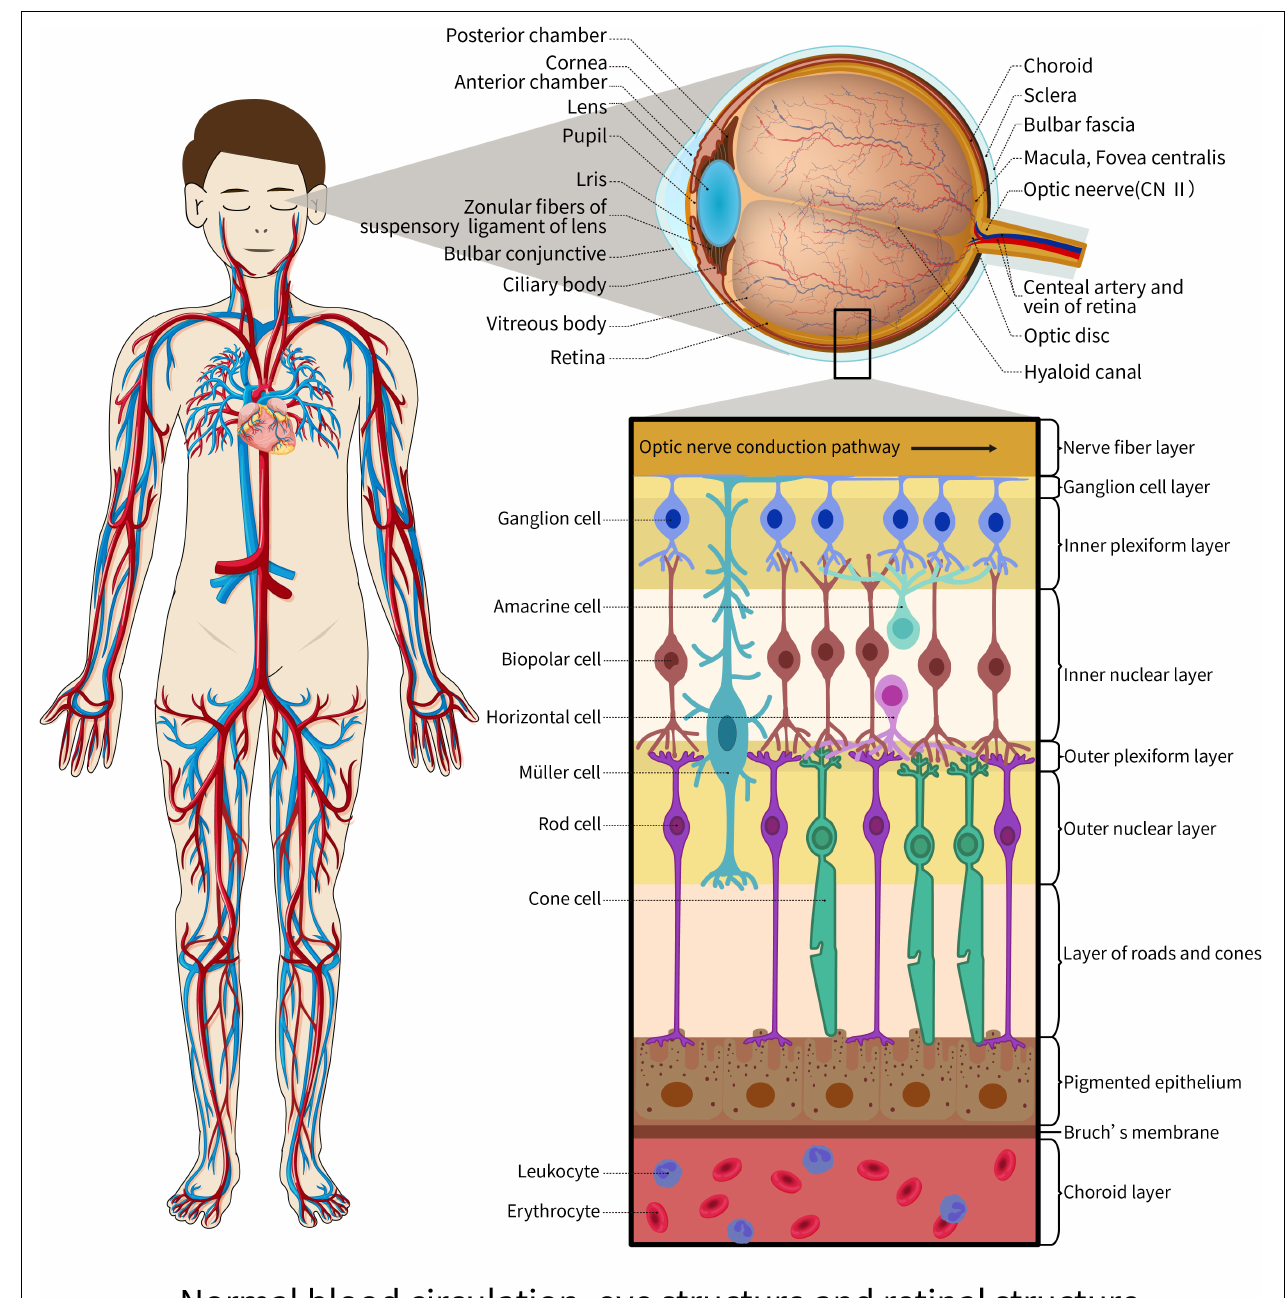
FIGURE 2 | Normal blood circulation, eye structure, and retinal